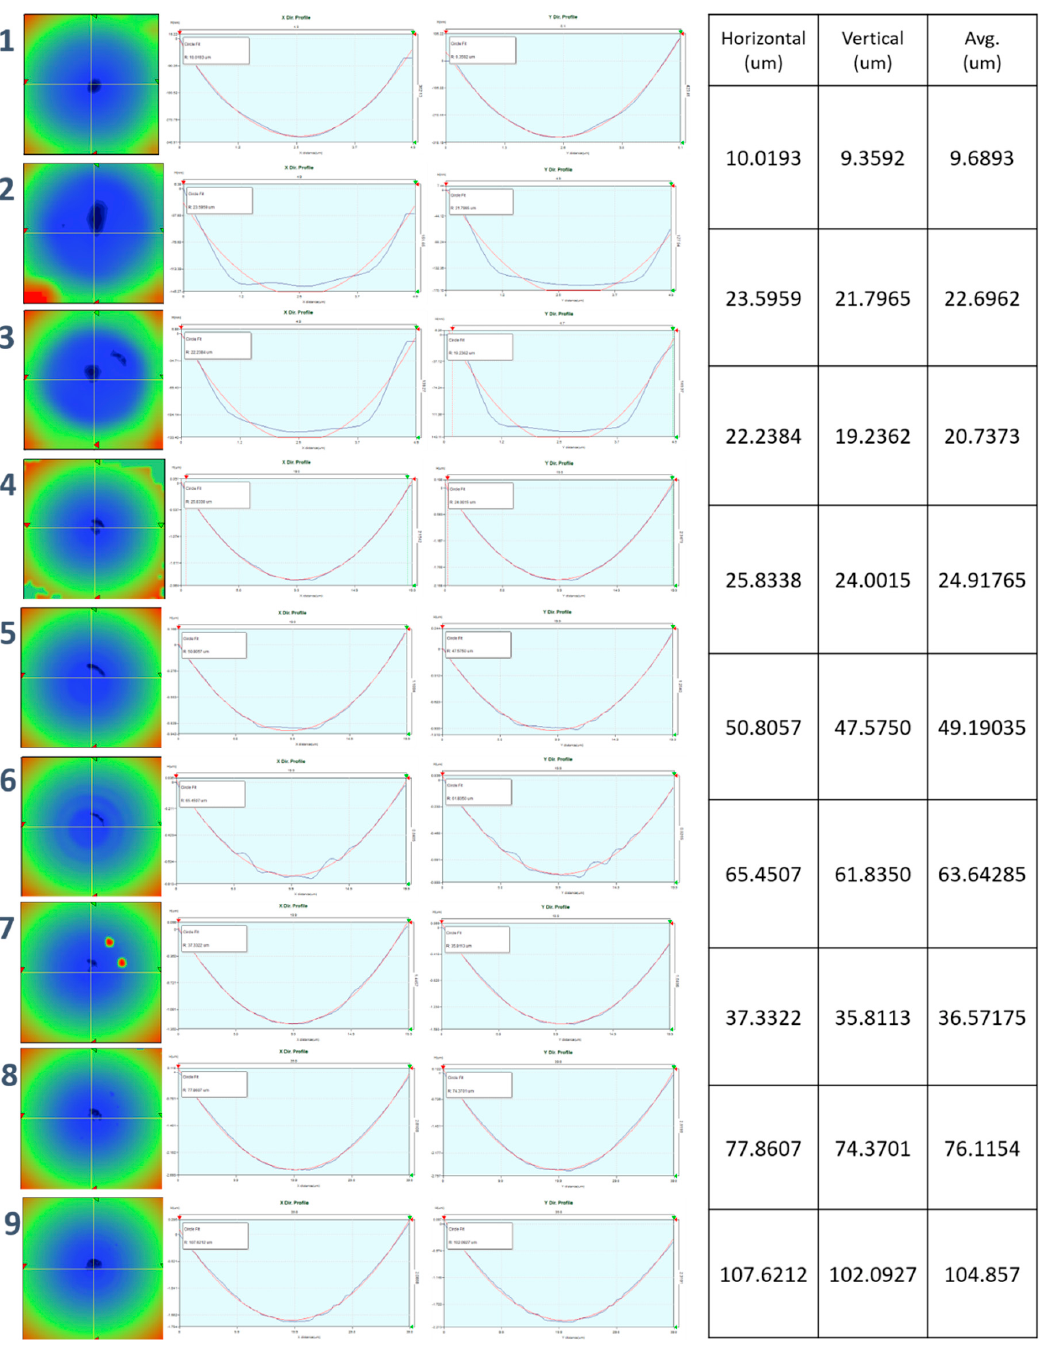
Figure A12. ROC measurement data for 1st mold replica (PDMS).